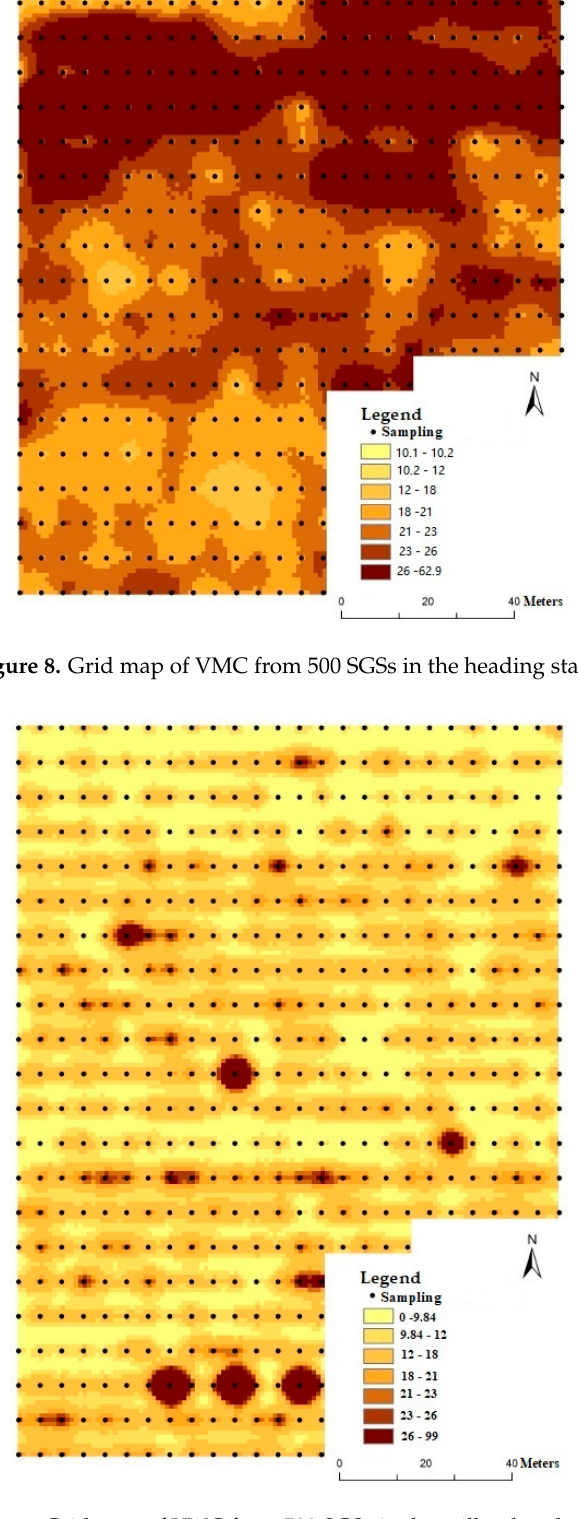
Figure 9. Grid map of VMC from 500 SGSs in the milky dough stage.